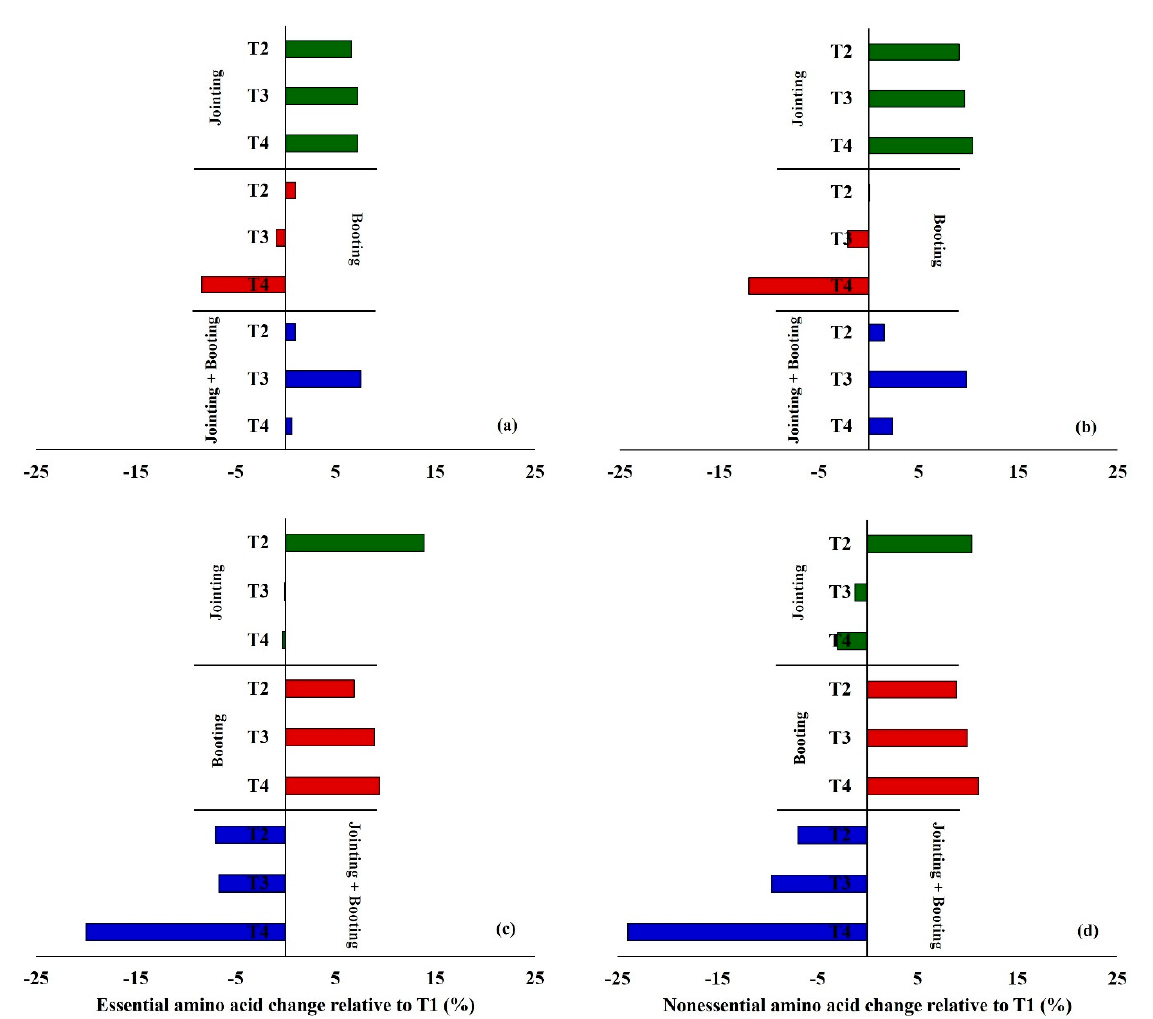
Figure 4. Changes in essential amino acids and nonessential amino acids of Yangmai16 ( a,b ) and Xumai30 ( c , d ) relative to T1 under different low-temperature treatments.